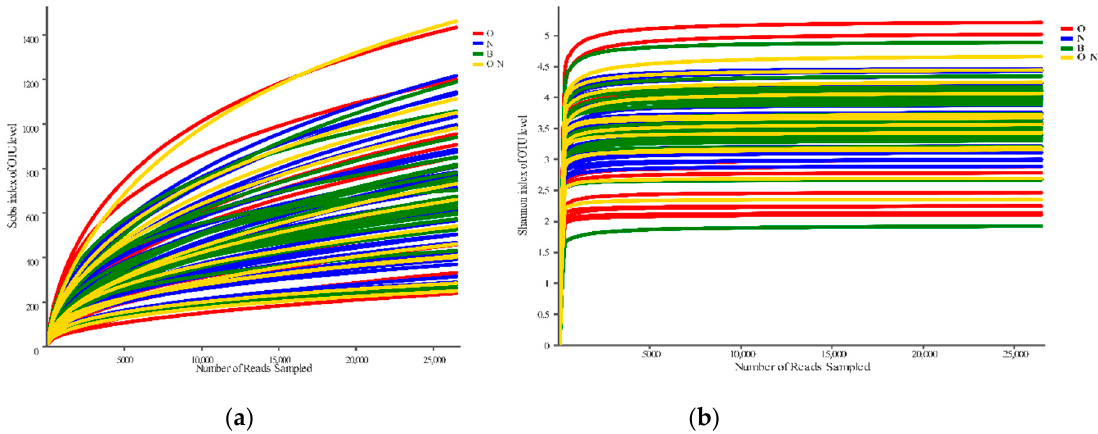
Figure 3. Rarefaction curves of each sample at a cutoff level of 3% sequence dissimilarity: ( a ) Sample-based rarefaction curves (Sobs) for four groups; ( b ) species richness estimators (Shannon) for four groups.